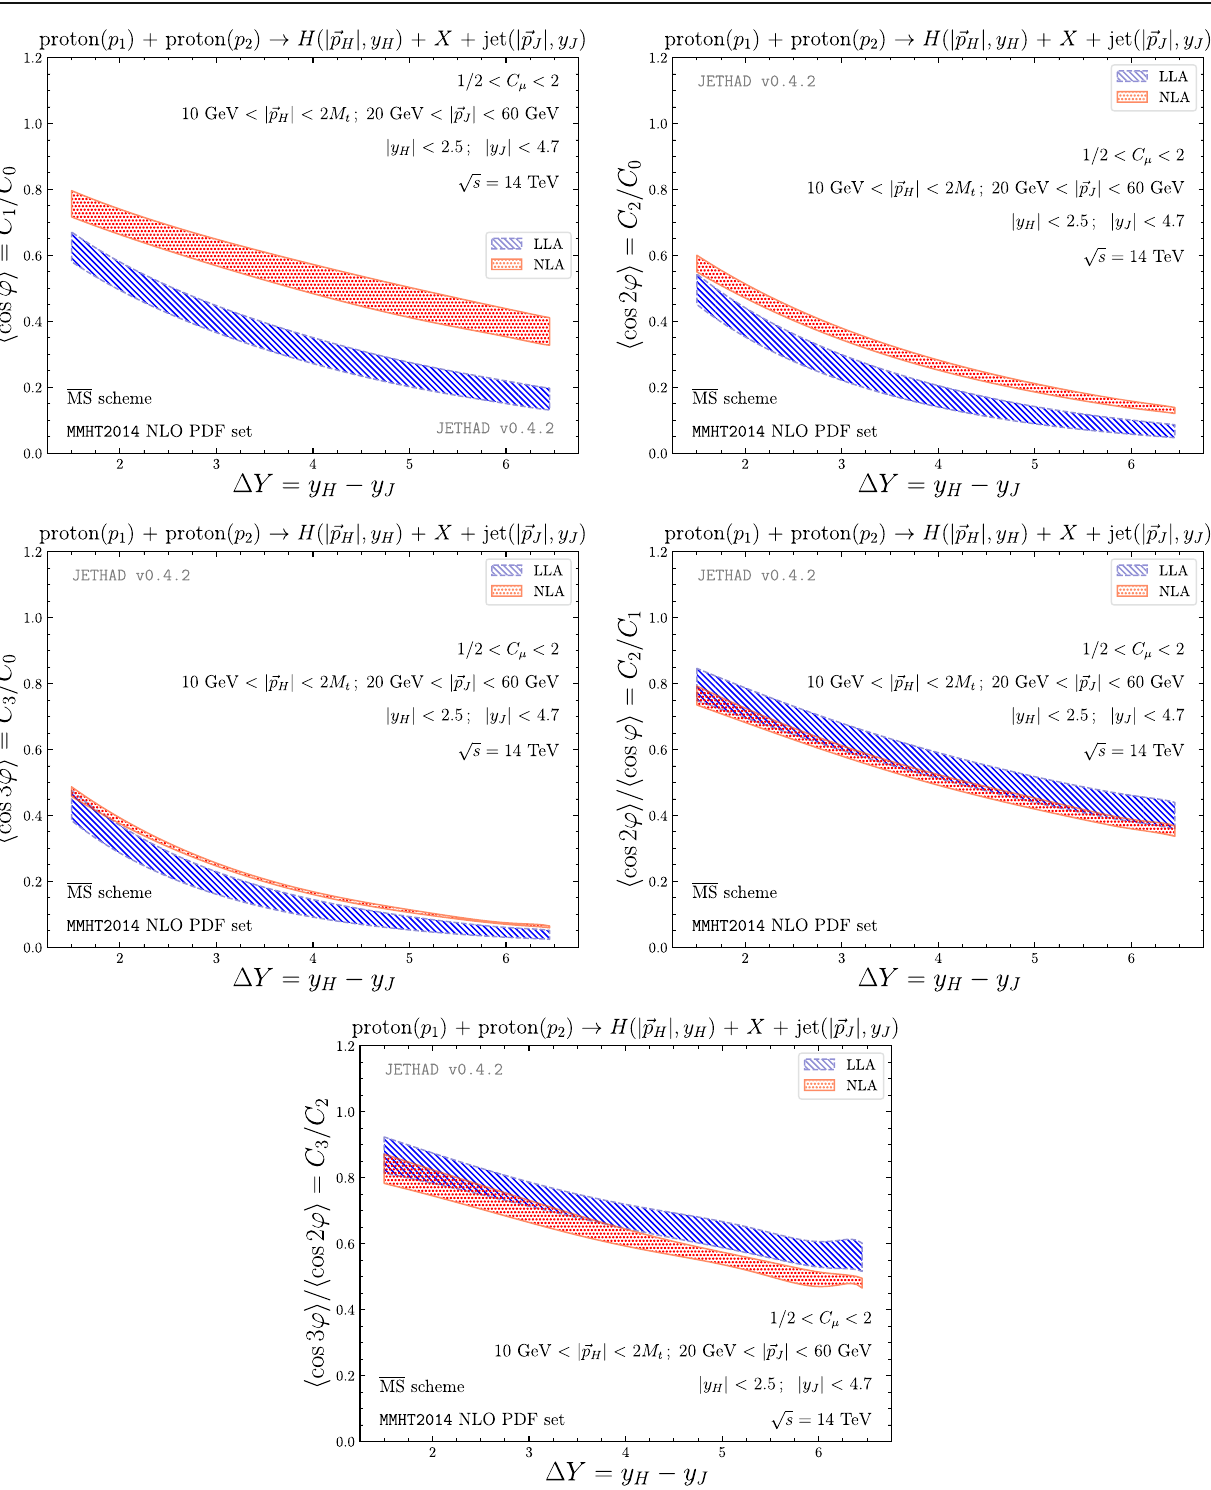
Fig. 6 (cid:6) Y -dependence of several ratios R nm ≡ C n / C m , for the inclusive Higgs-jet hadroproduction in the p T - asymmetric configuration and for √ s = 14 TeV. Shaded bands give the combined effect of the scale variation with the uncertainty coming from the phase-space numerical